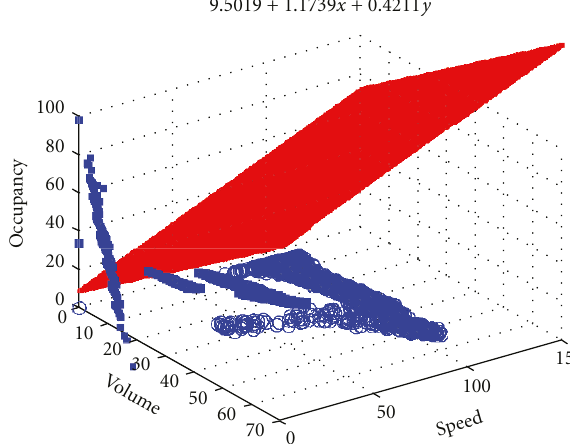
Figure 13: Flow Tra ffi c Plane for F-SVM of OAAM.